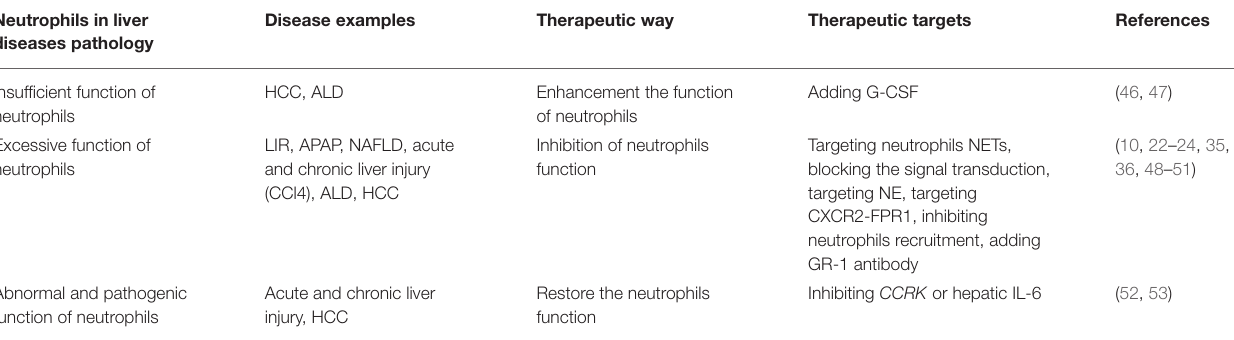
TABLE 1 | Therapeutic targets of neutrophils in liver